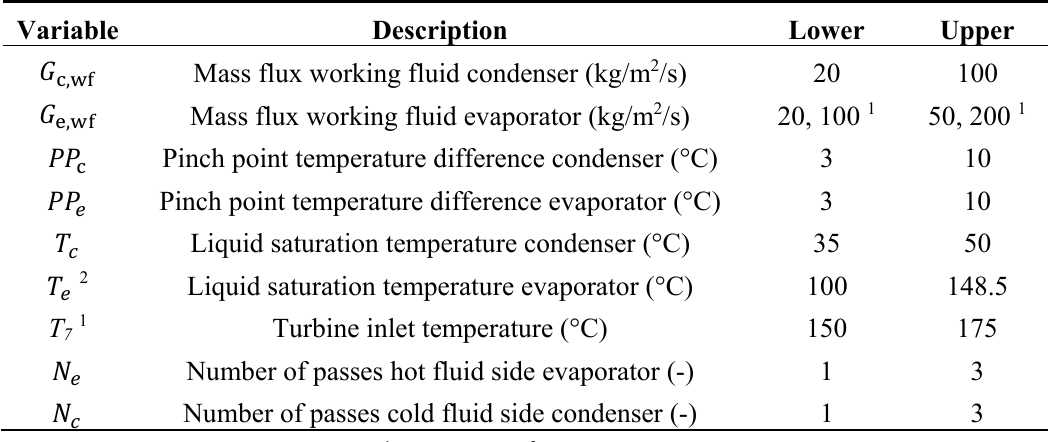
Table 8. Decision variables and their